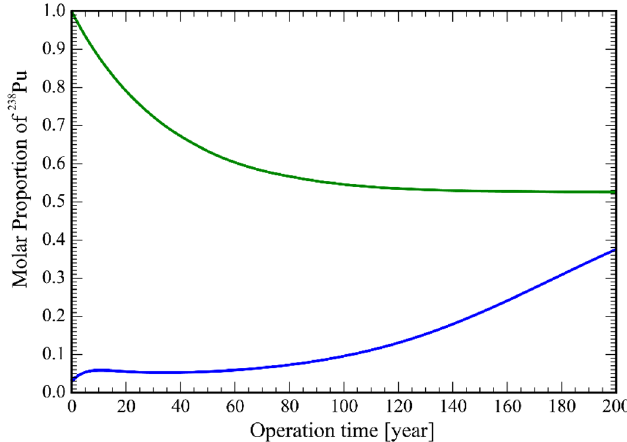
Fig. 3. Time evolution of the 238 Pu content in the total Pu for a reactor started with 233 U (green curve) and with enriched@13% U+ TRU (blue curve).